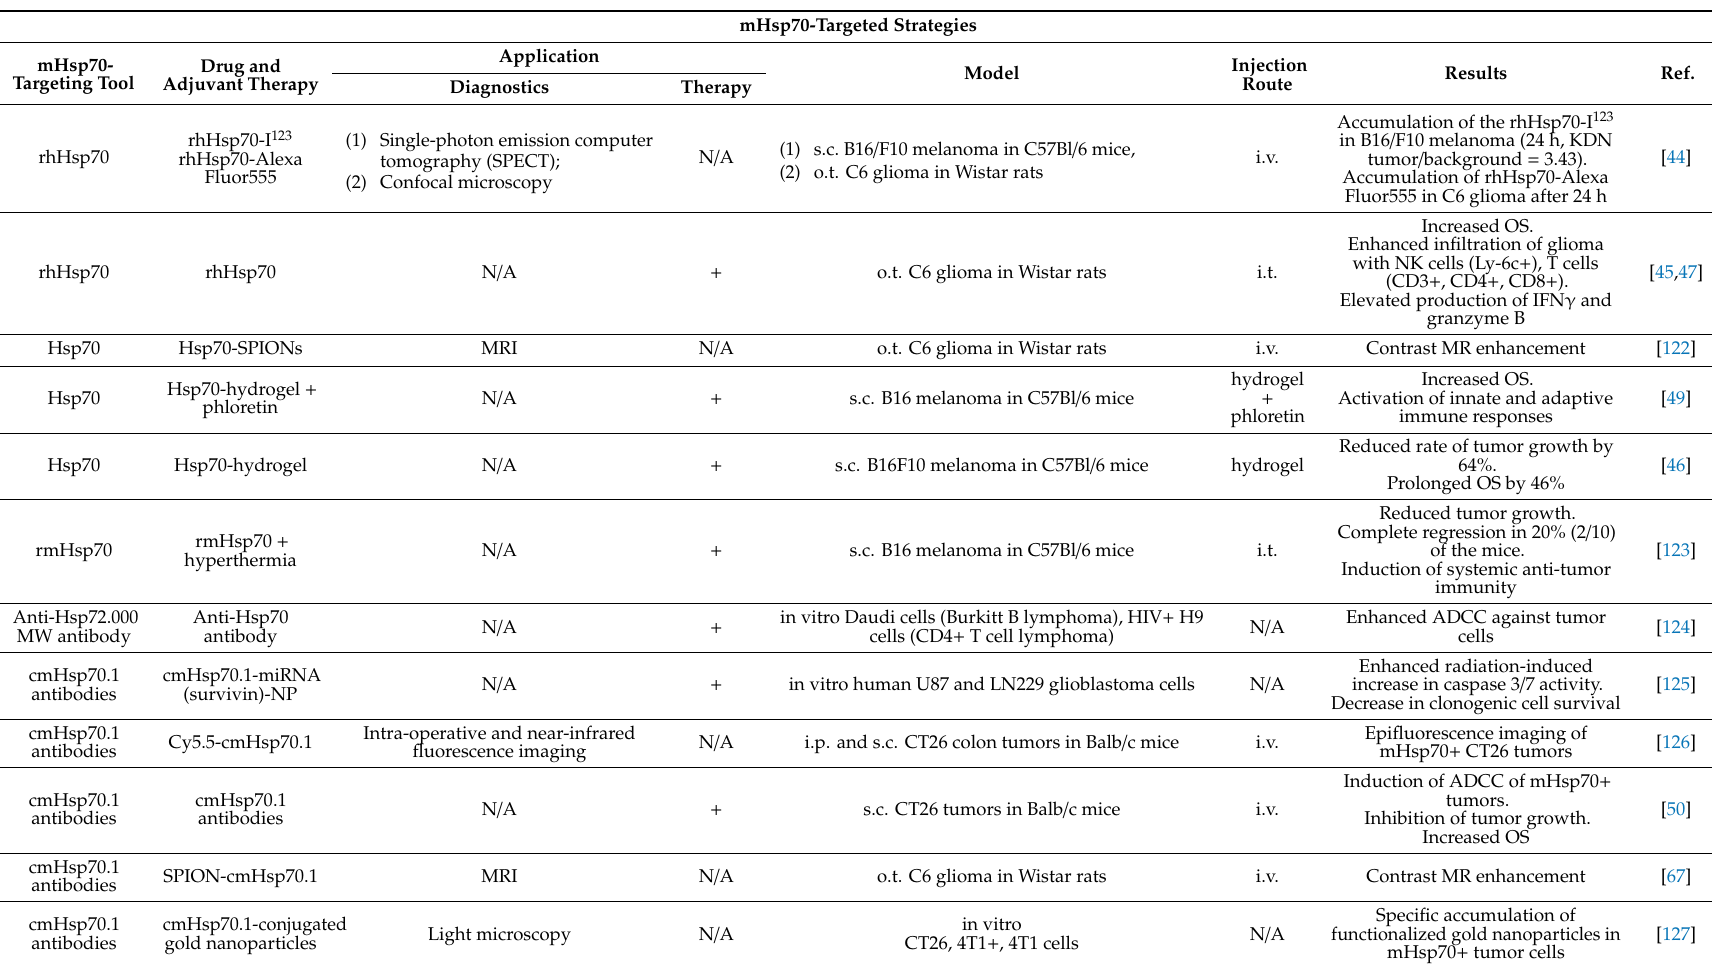
Table 1. Application of the membrane-associated Hsp70 and GRP78 for tumor